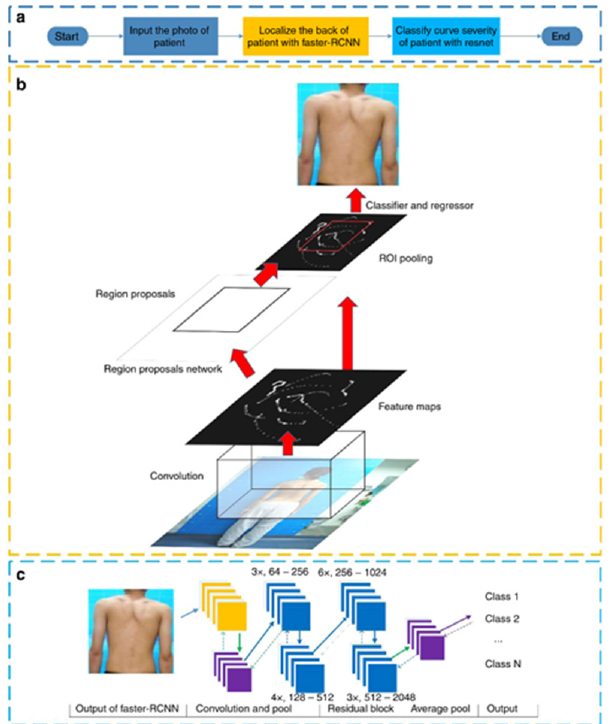
Figure 9. Block diagram and the architectures of Faster-RCNN and Resnet [15]: Yang, J. et al. ( a ) The entire DLA workflow; ( b ) The architecture and workflow of Faster-RCNN; ( c ) The architecture of Resnet. [15]’s algorithm using convolutional layer to obtain a feature map of the back. The algorithm finds the ROI in the feature map, pools it, and classifies it with a